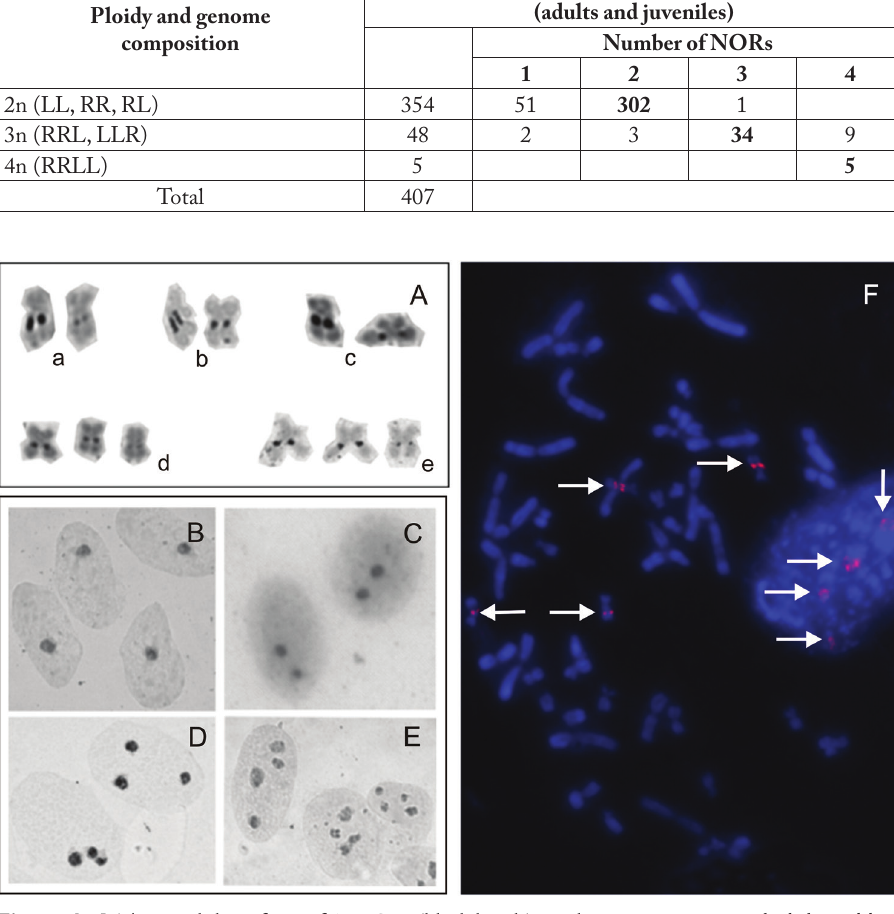
Figure 1. A The variability of size of AgNORs (black bands) on chromosomes 10 a Pelophylax ridibun- dus b P. lessonae c P. esculentus RL d P. esculentus RRL e P. esculentus LLR B–E Interphase nuclei of P. B diploid RL with 1 AgNOR C diploid RL esculentus with Ag-nucleoli visualized as black dots by AgNO 3 with 2 AgNORs D triploid RRL with 3 AgNORs E triploid RRL with 4 AgNORs F metaphase chromo- somes and interphase nuclei of the same tetraploid P. esculentus RRLL with 4 sites of hybridization with 28S rDNA probe (FISH)